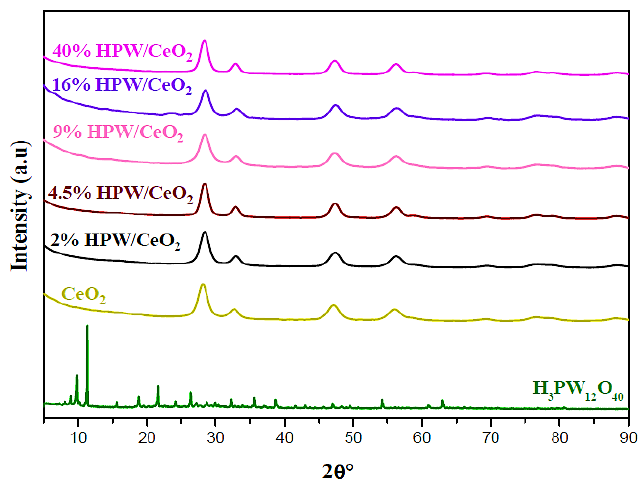
Figure 1. XRD patterns of CeO 2 , H 3 PW 12 O 40, and HPW/CeO 2 (2, 4.5, 9, 16, and 40 wt% W).